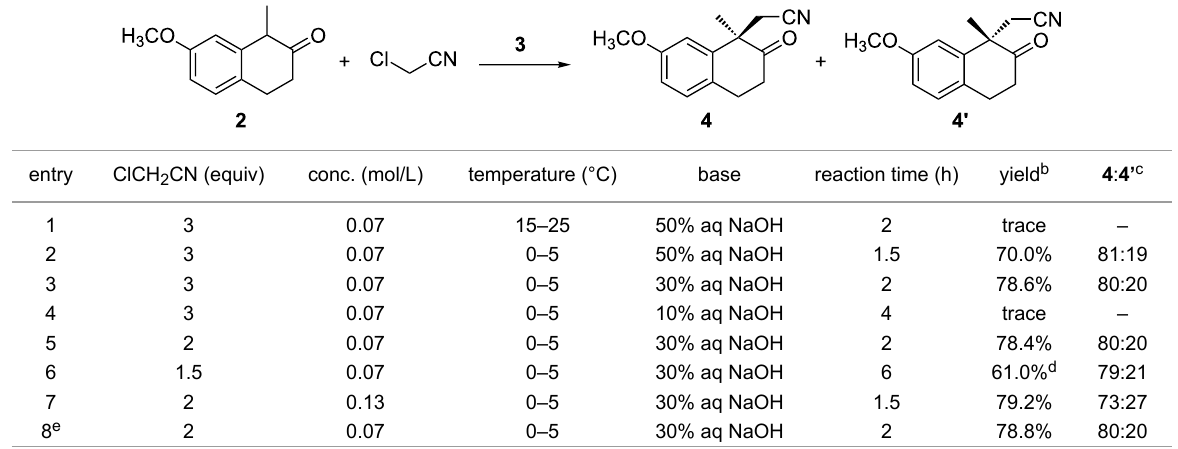
Scheme 3: Asymmetric synthesis of 1 .